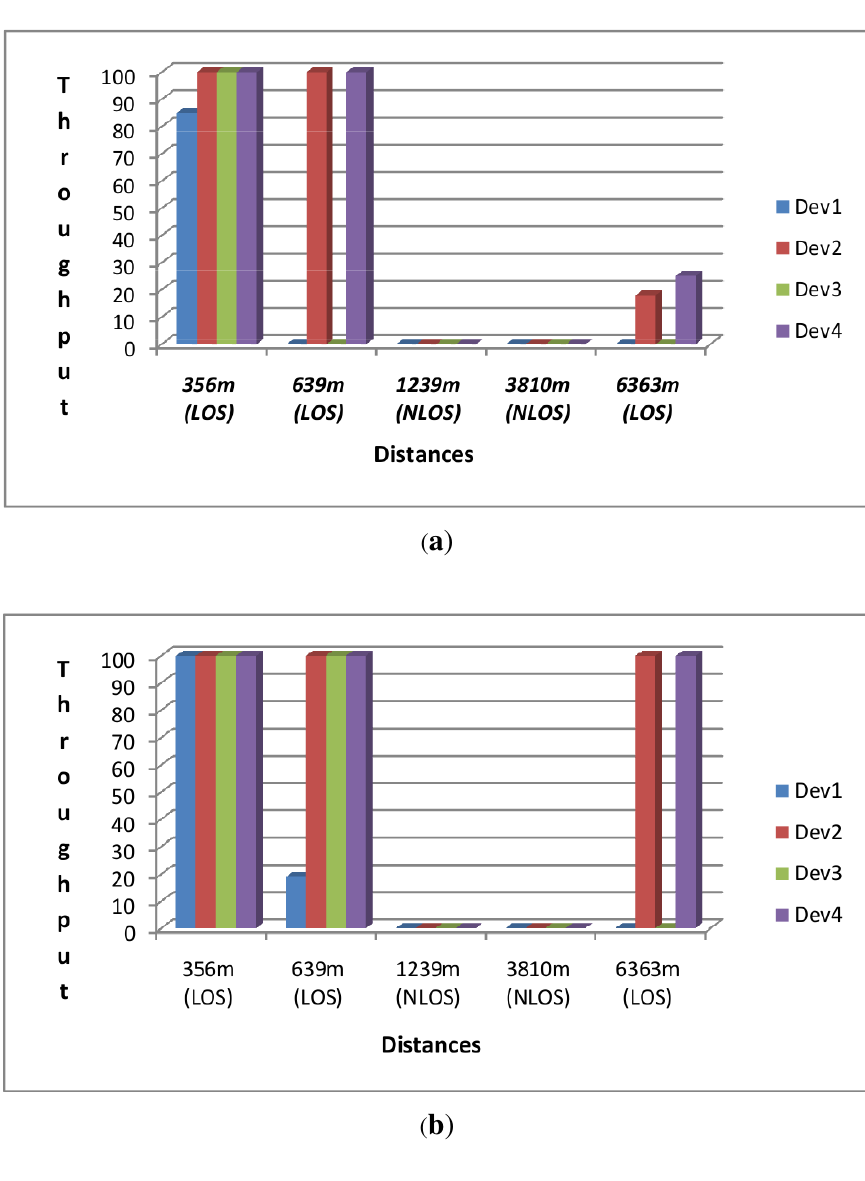
Figure 6. Waspmote throughput on Long Distances. ( a ) Throughput at 2 dBi (in %); ( b ) Throughput at 5 dBi (in %).